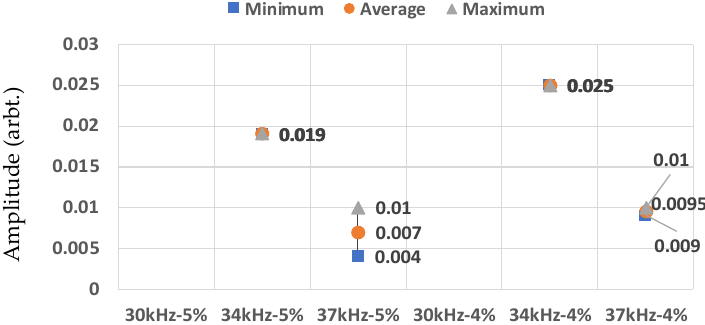
Figure 17. Minimum, average, and maximum values of method one of the second test cases.